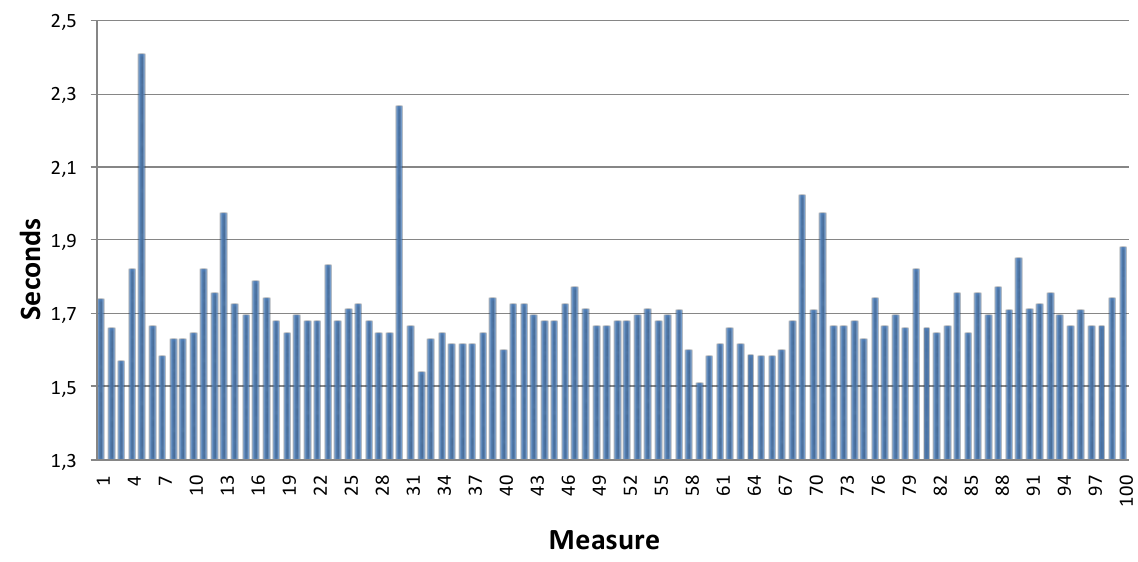
Figure 21. Total time for a very large amount of